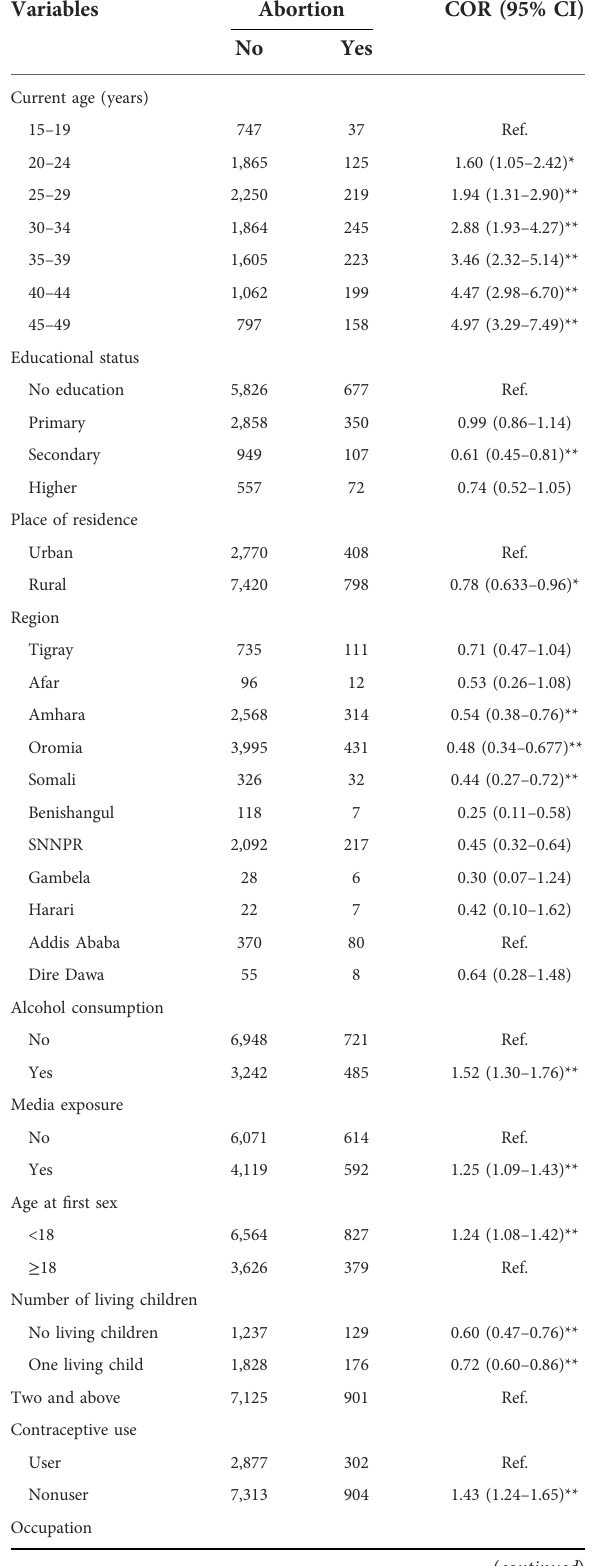
TABLE 2 Description of background factors associated with abortion and bivariable multilevel mixed-effects logistic regression in COR.